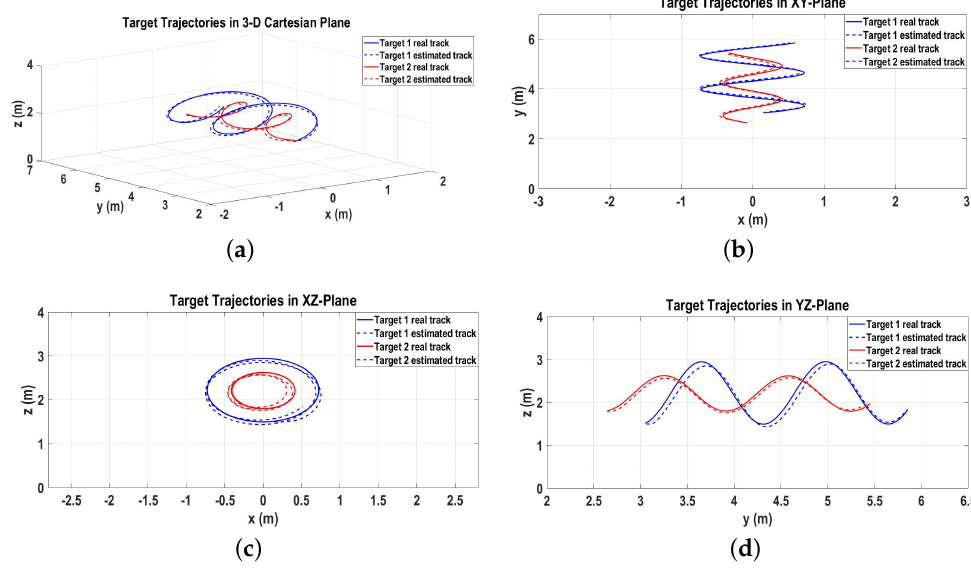
Figure 6. Real and estimated target tracks for Scenario 1. ( a ) Real and estimated target tracks in 3D Cartesian space; ( b ) Real and estimated target tracks in xy-plane; ( c ) Real and estimated target tracks in xz-plane; ( d ) Real and estimated target tracks in yz-plane.